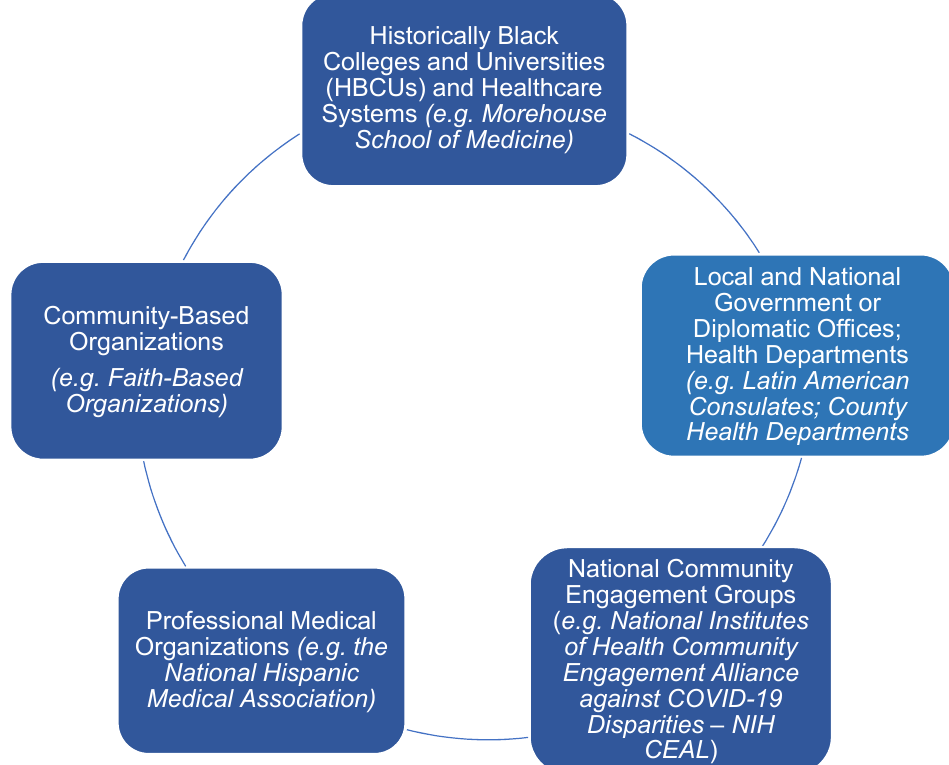
Figure 1. Key collaborators for inspiring COVID-19 vaccine confidence in African American and Latino communities.